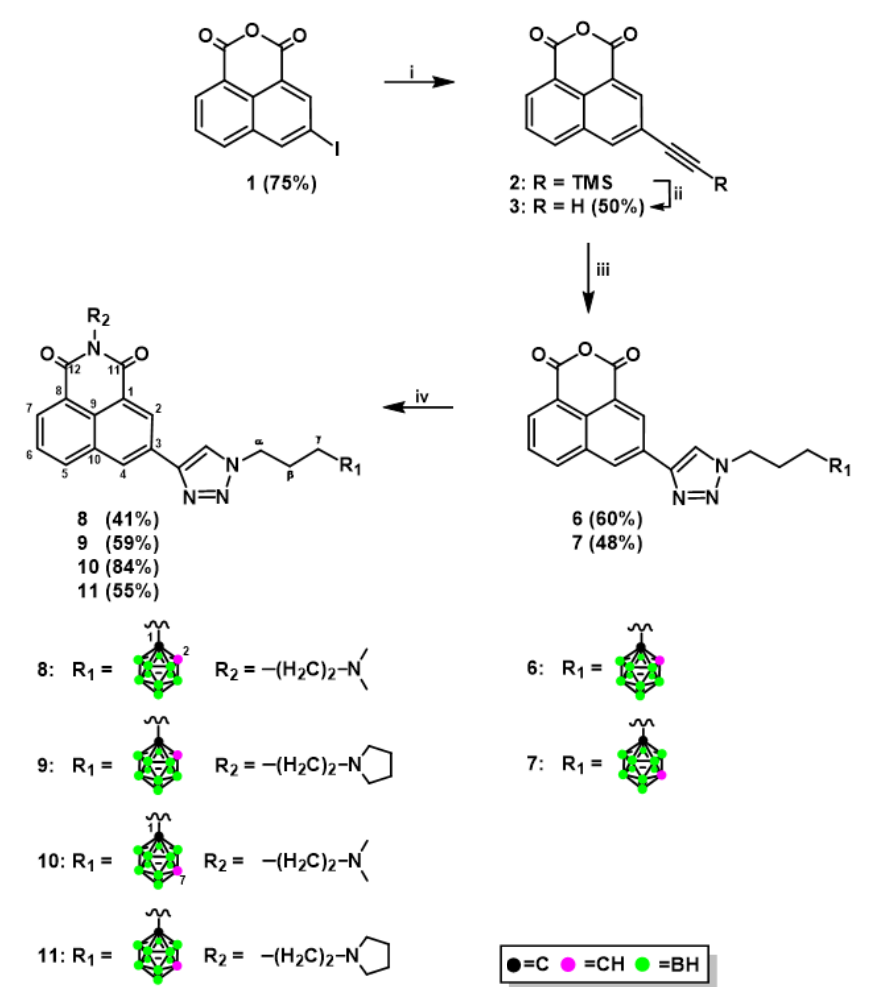
Scheme 1. Synthesis of naphthalimide– ortho -/ meta -carborane conjugates 8 – 11 . Reagents and